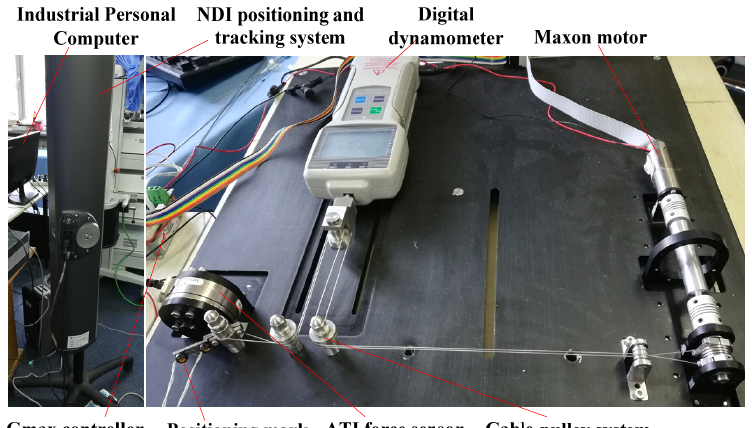
Figure 8. Experiment to investigate the transmission characteristics of a cable-pulley system.